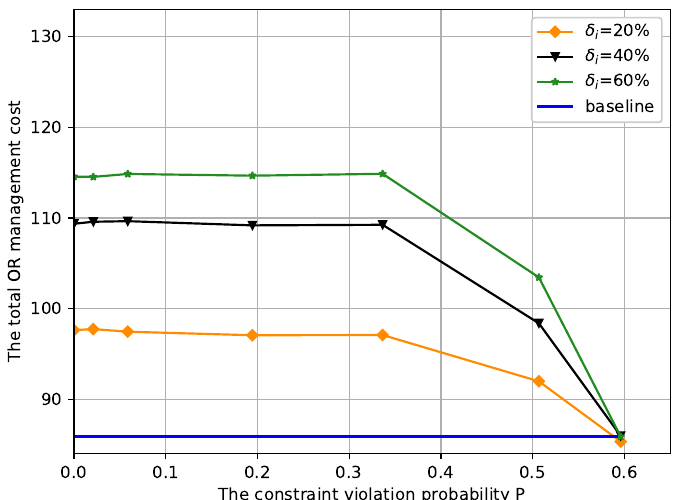
Figure 7. The total OR management cost versus constraint violation probability P under different perturbation factors δ i